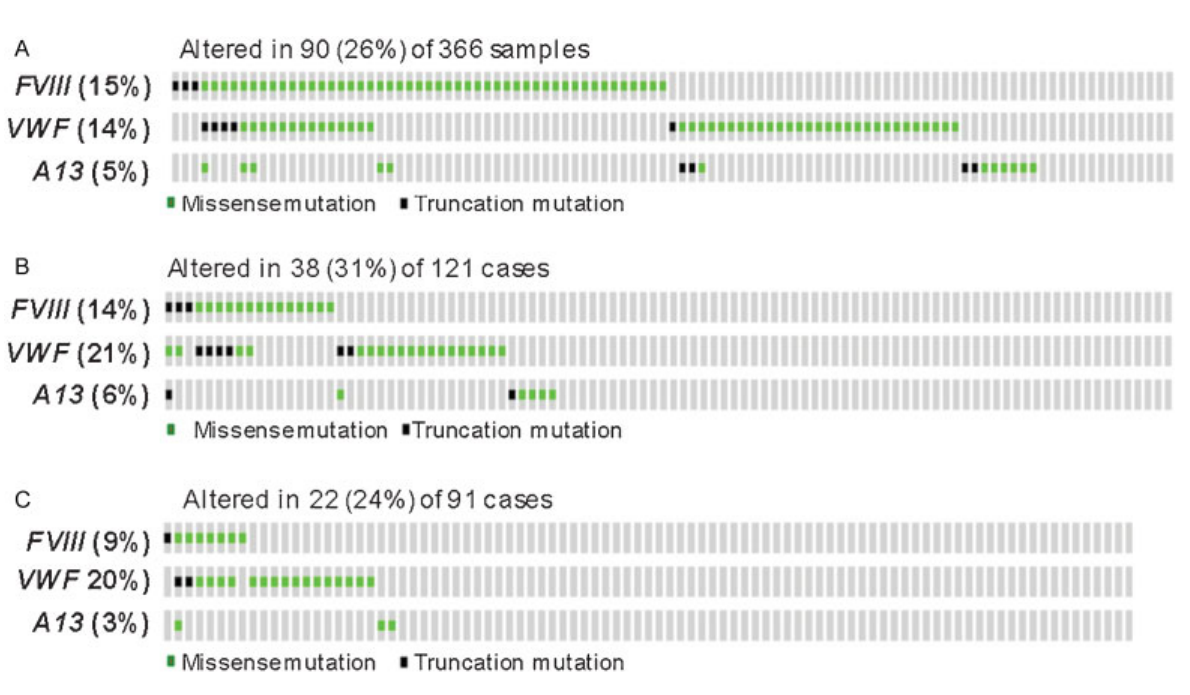
Fig. 2 Mutation pro fi les of FVIII, VWF , and ADAMTS13 found in cutaneous melanoma of three datasets. ( A ) TCGA provisional; ( B ) broad cell, 2012; and ( C ) Yale Nature Genetics, 2012.